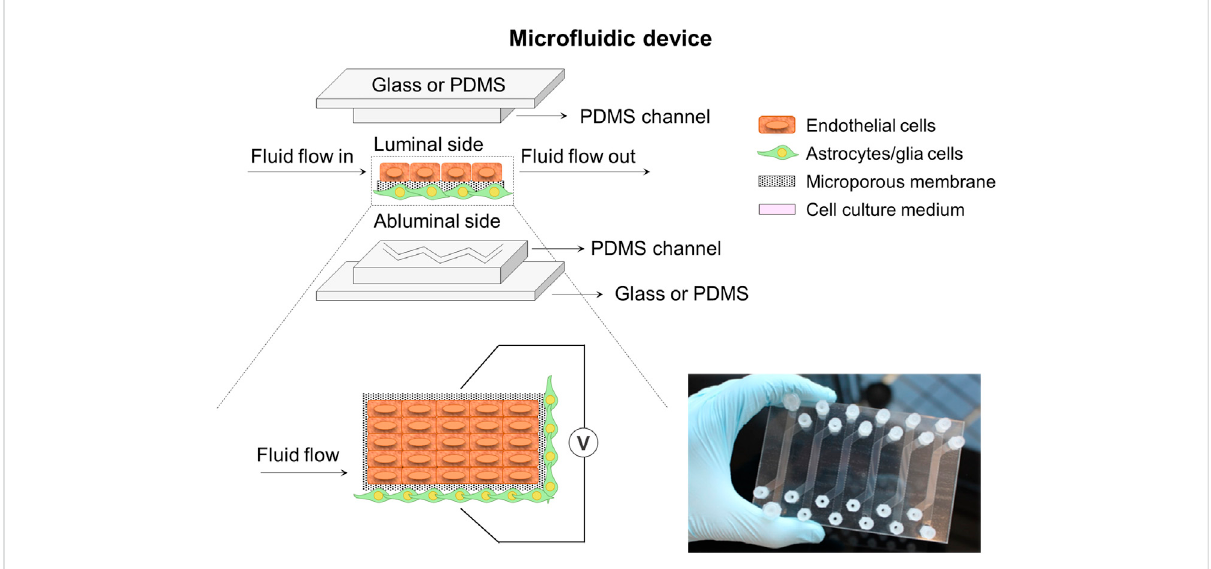
FIGURE 4 Schematicillustrationofamicro fl uidic devicesystem composed oftwomicrochannels. These microchannels withspeci fi cpatterns cross each other perpendicularly and are separated by a fl at porous membrane to allow cell co-culture. The system could incorporate some electrodes to help with the TEER measurement at both sides of the membrane. A picture of a home-made micro fl uidic device in plate format con fi guration encompassing six conditions in parallel is also presented (Choublier et al.,